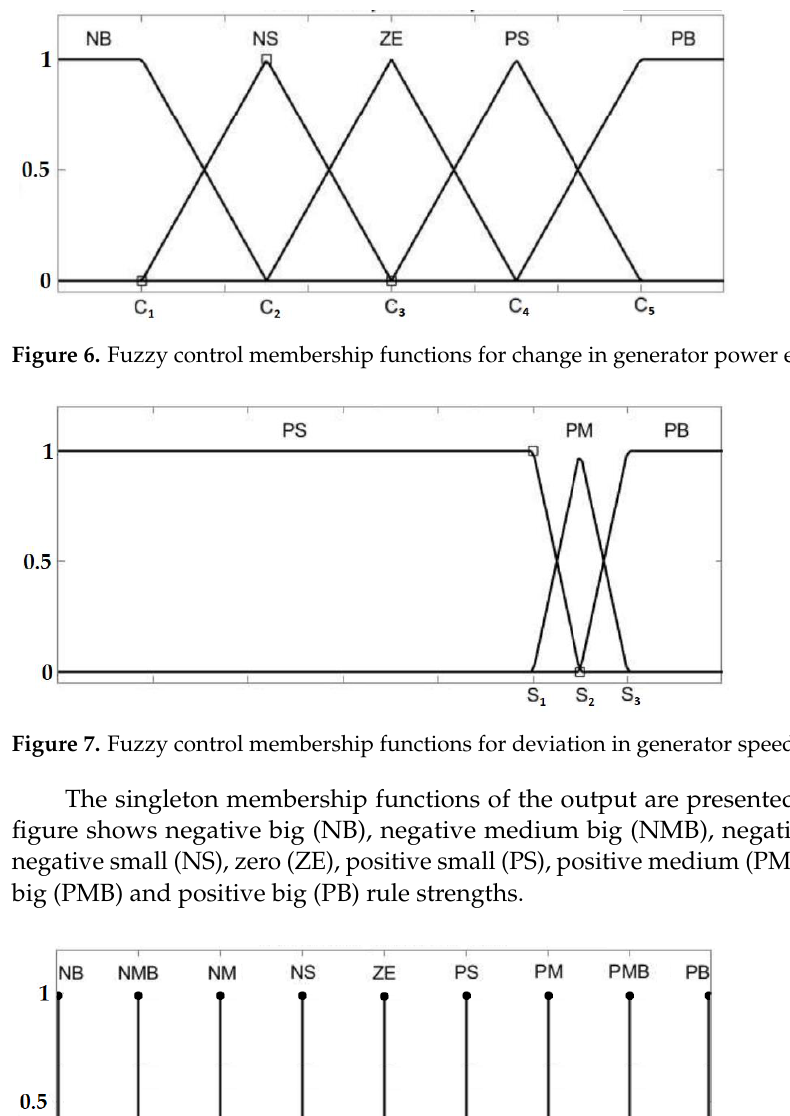
Figure 5. Fuzzy control membership functions for generator power error.